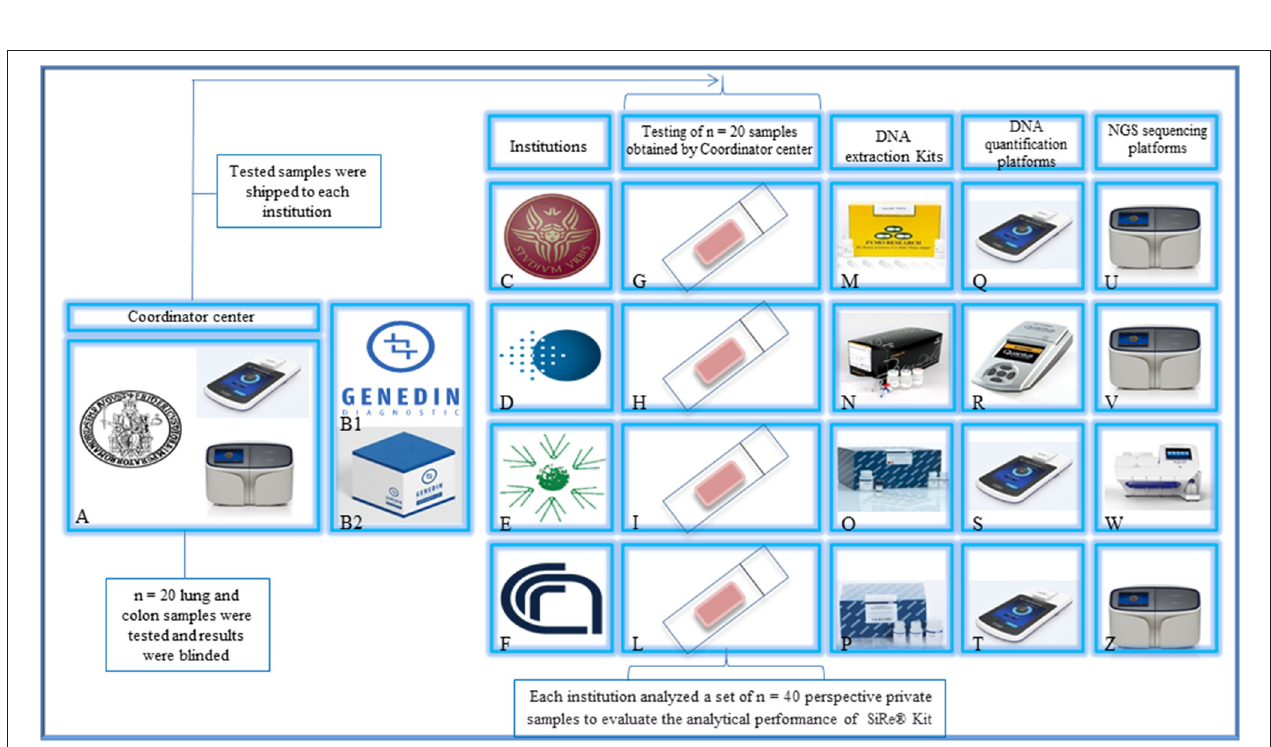
FIGURE 2 | Study design. The Department of Public Health of the University of Naples Federico II (A) and Genedin s.r.l. (a spin-off of the Department of Public Health, University of Naples Federico II) (B1) develop the SiRe ® NGS panel kit (B2) . The kit was distributed to n = 4 different institutions [ (C) University La Sapienza—Rome, (D) Istituto Oncologico Europeo—Milan, (E) Istituto Tumori Giovanni Paolo II—Bari, (F) Consiglio Nazionale delle Ricerche—Sassari] to analyze a series of n = 160 colon/lung routine samples (G–L) ( n = 40 for each institution) following the local NGS workflow, for DNA extraction (M–P) , quantification (Q–T) , and sequencing on IonTorrent platforms (U–Z) , after an alignment phase on a common set of n = 20 shared samples. Permission to publish the figure was obtained by Genedin s.r.l. (a spin-off of the Department of Public Health, University of Naples Federico II).